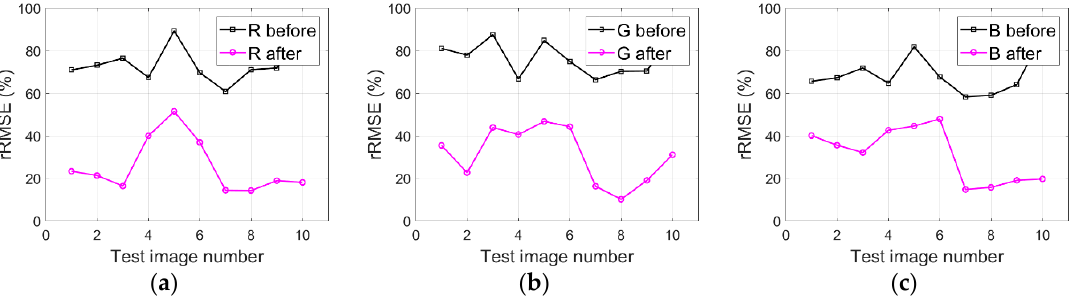
Figure 17. IRB method generalization analysis for WV3-Rio images in terms of R, G, and B components. ( a ) R. ( b ) G. ( c ) B .